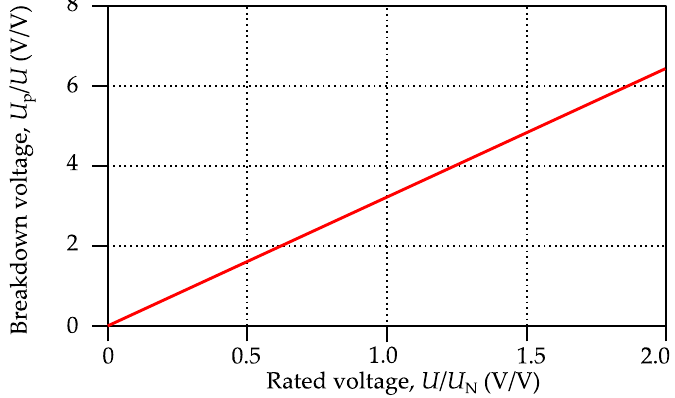
Figure 9. Characteristic U P = f( U ).